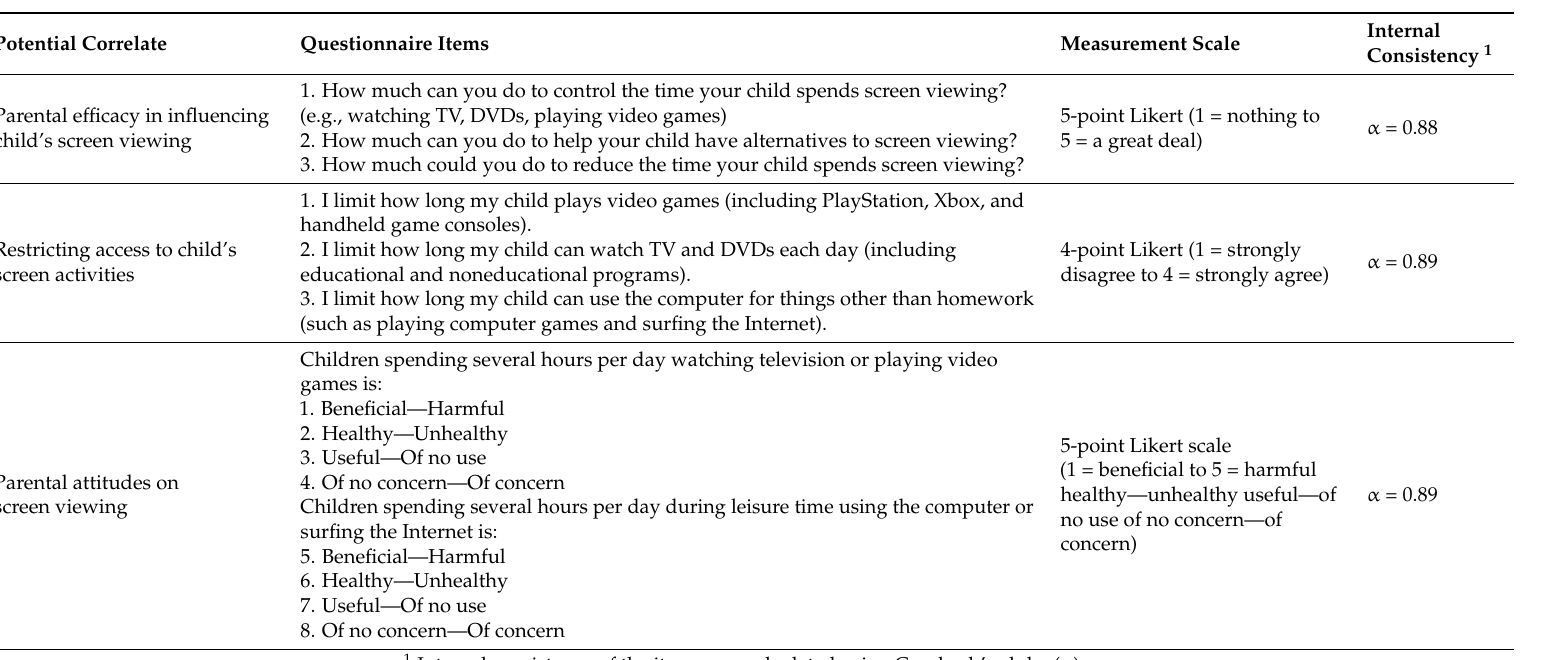
Table A1. Descriptions of questionnaire items on parenting